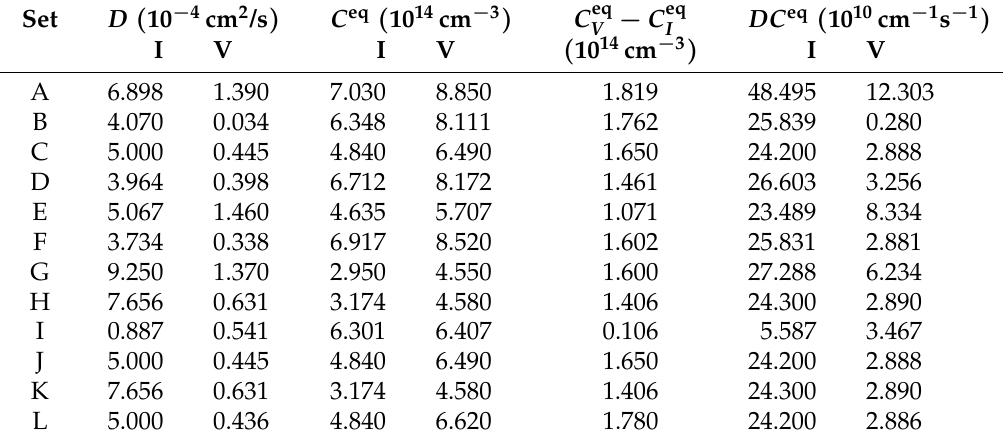
Table 2. Values of point defect parameters at the melting